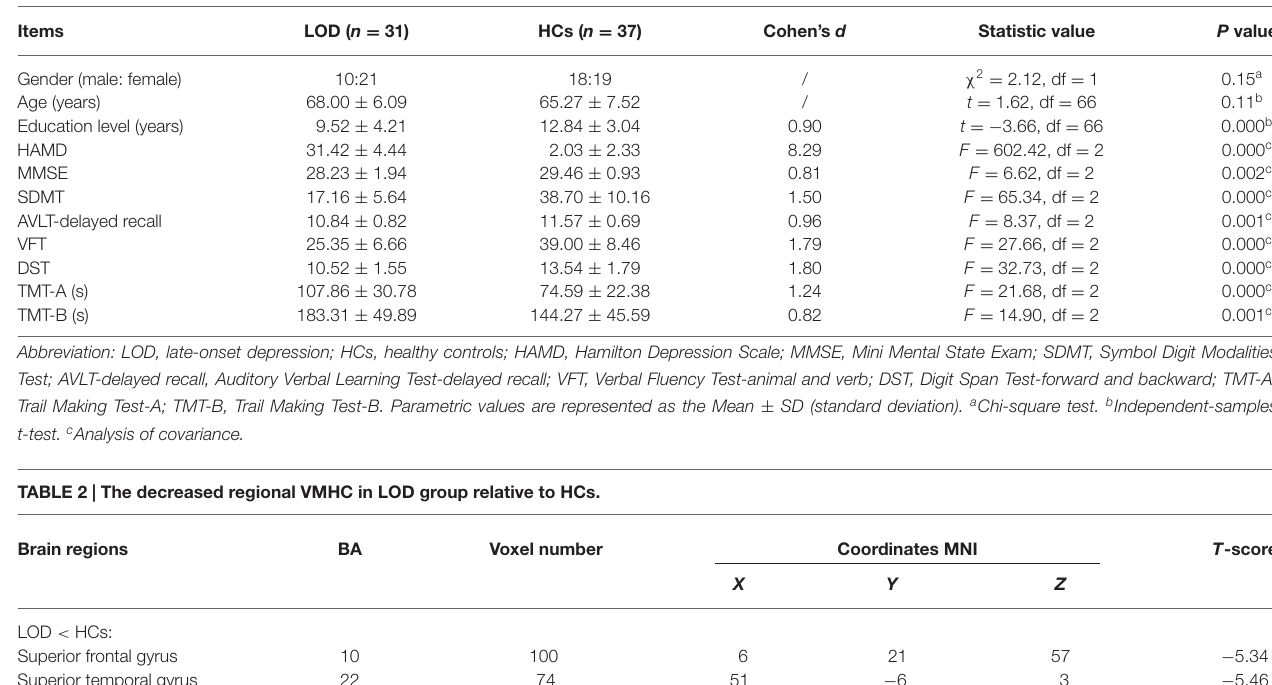
TABLE 1 | Demographic and clinical characteristics of LOD and HCs.